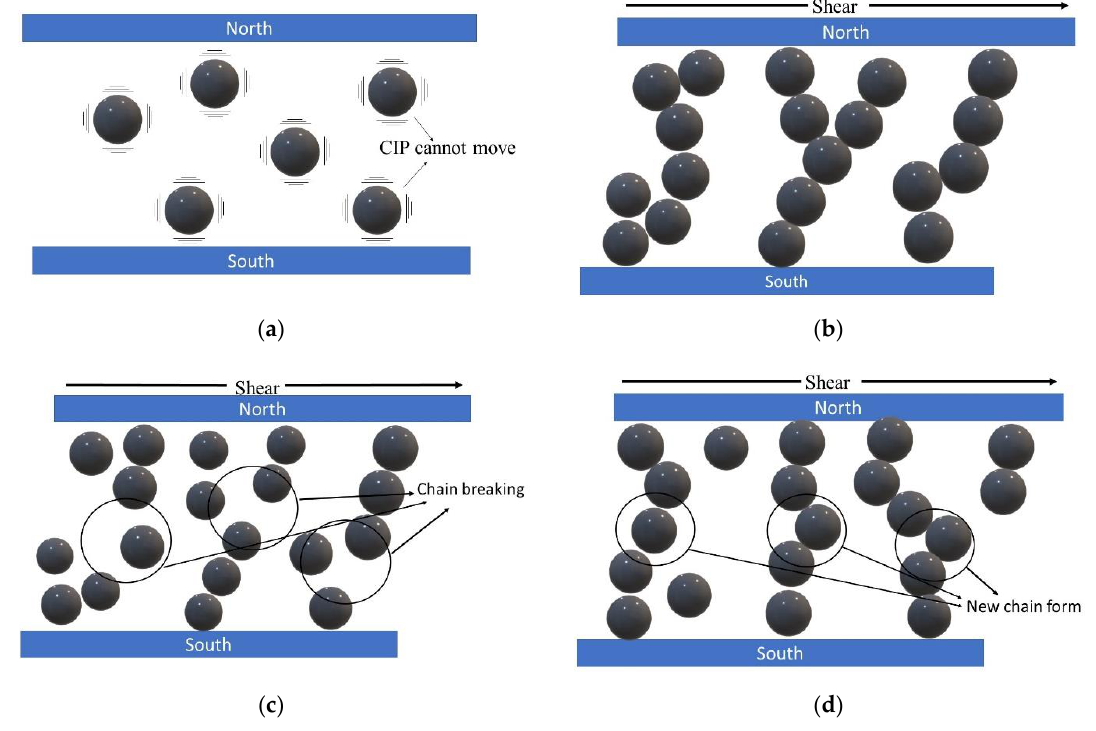
Figure 10. The illustration of CIP movement in shear mode-MR brake in ( a ) absence of magnetic field, ( b ) presence of magnetic field, ( c ) chain breaking, and ( d ) reformation of new chain.